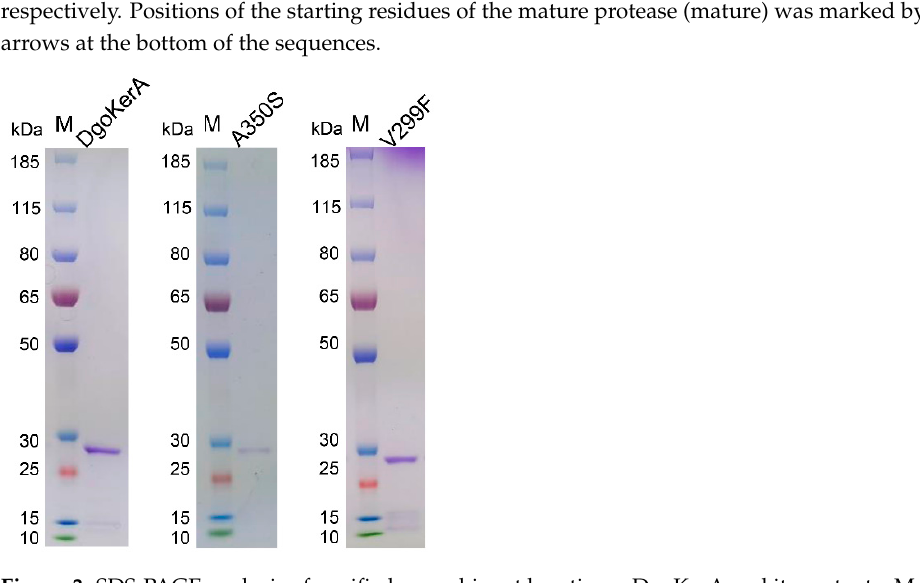
Figure 3. SDS-PAGE analysis of purified recombinant keratinase DgoKerA and its mutants. M means the protein standard marker line. Table 2. The enzymatic activities of several keratinases on 1% soluble keratin and feather powder.